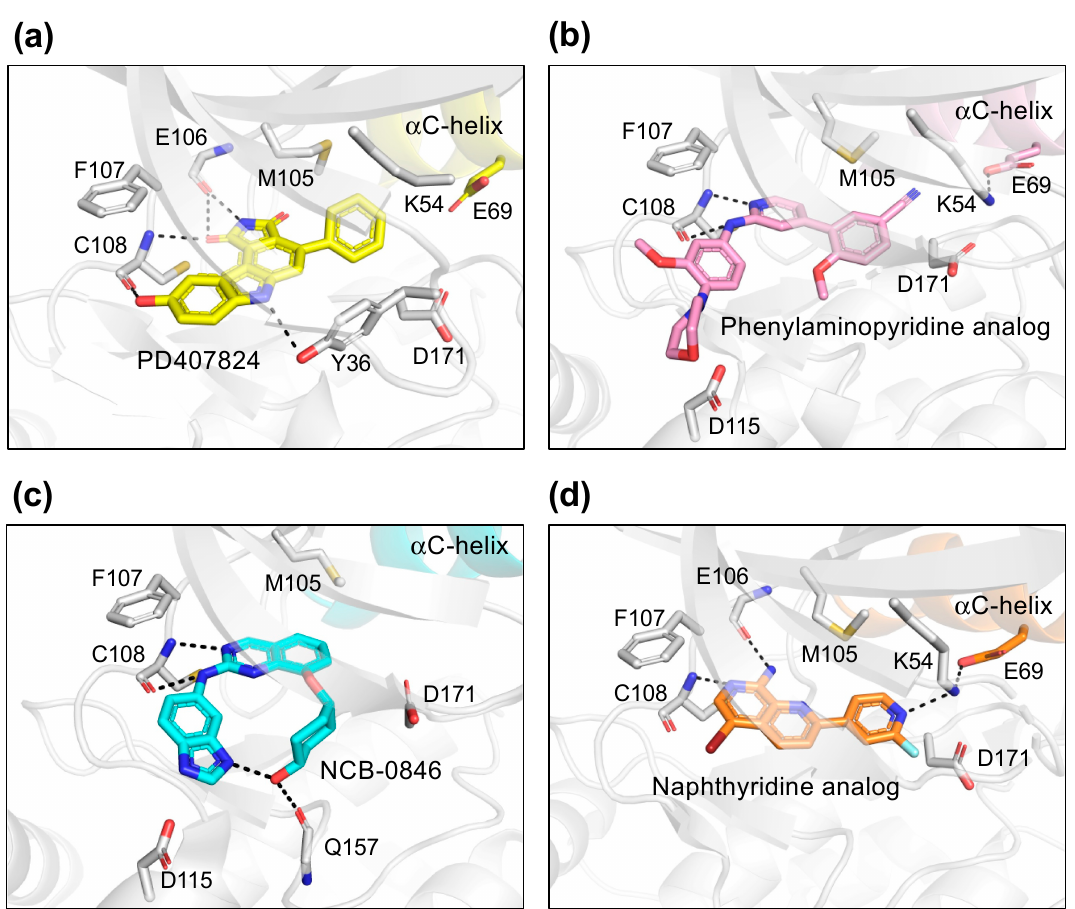
Figure 4. Binding modes of TNIK inhibitors. ( a ) PD407824 (PDB ID: 2X7F). ( b ) Phenylaminopyridine analog (PDB ID: 5AX9). ( c ) NCB-0846 (PDB ID: 5D7A). ( d ) Naphthyridine analog (PDB ID: 6RA5).